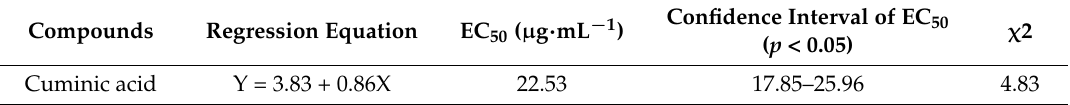
Table 1. The effect of cuminic acid on FON colony growth.